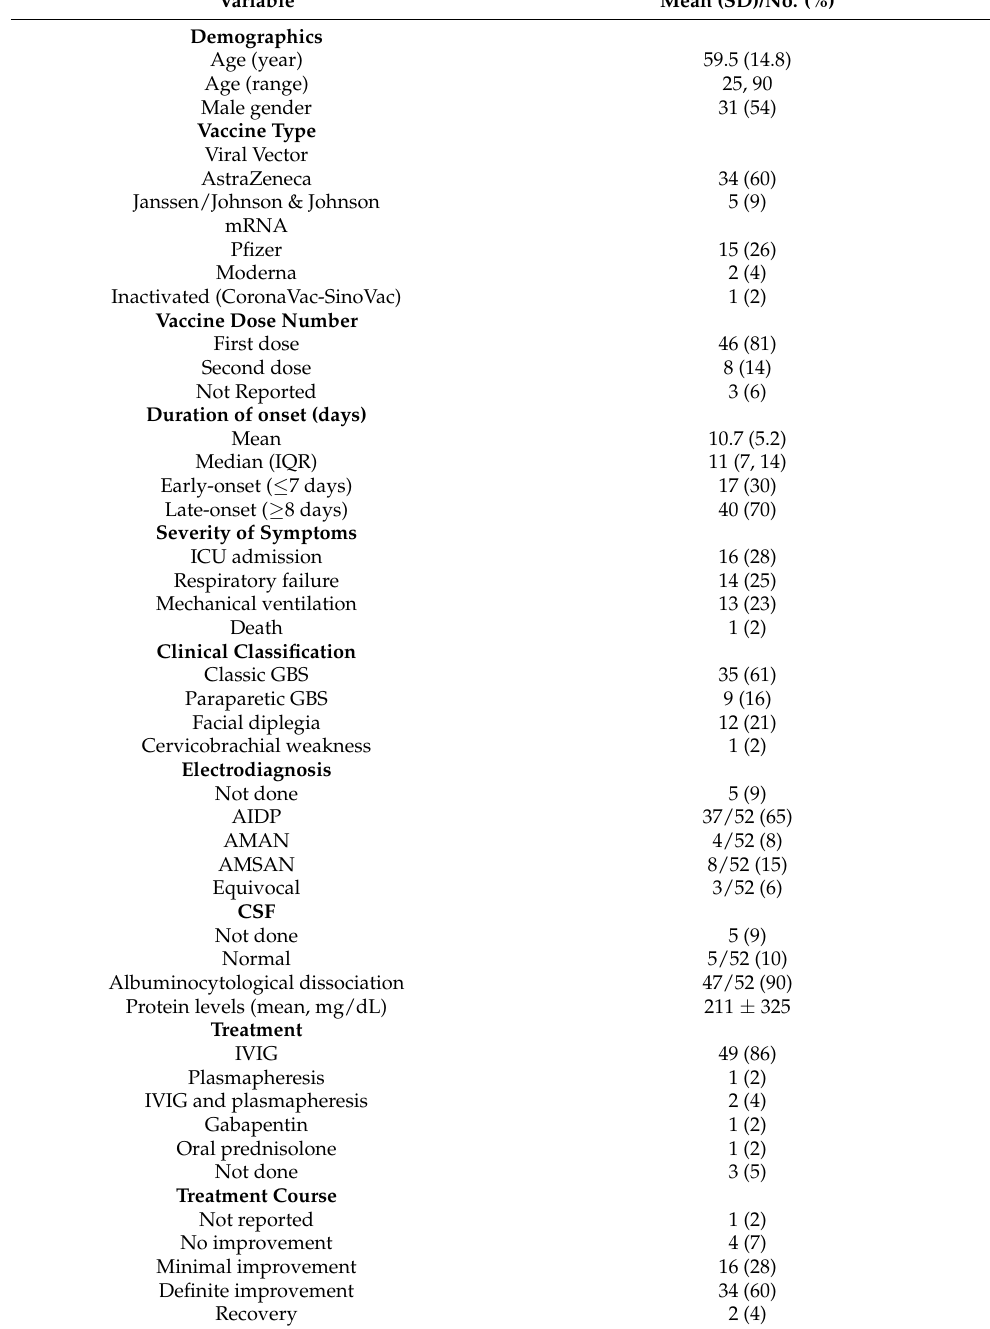
Table 1. Summary of demographics, vaccine data, onset duration, severity and outcomes of patients with Guillain–Barr é Syndrome, n =